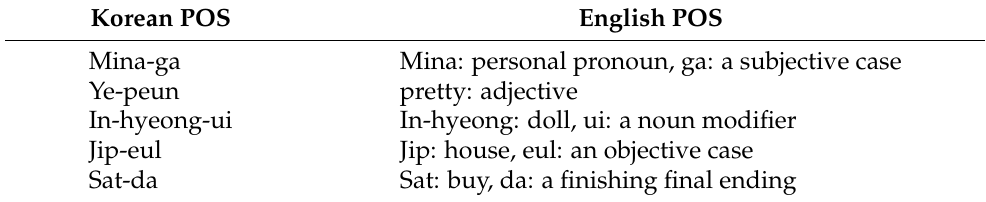
Table 3. Extraction of sentiment-target